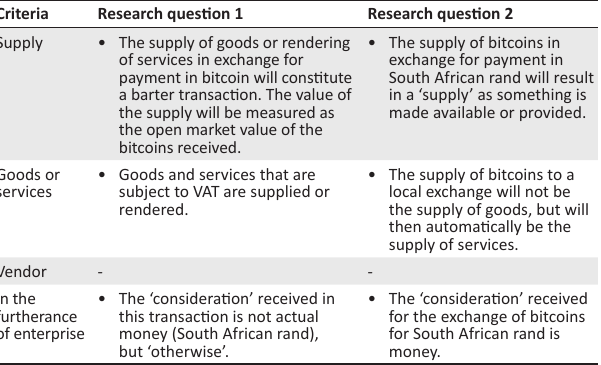
TABLE 3: Summary of conclusion based on interpretation of the Act.